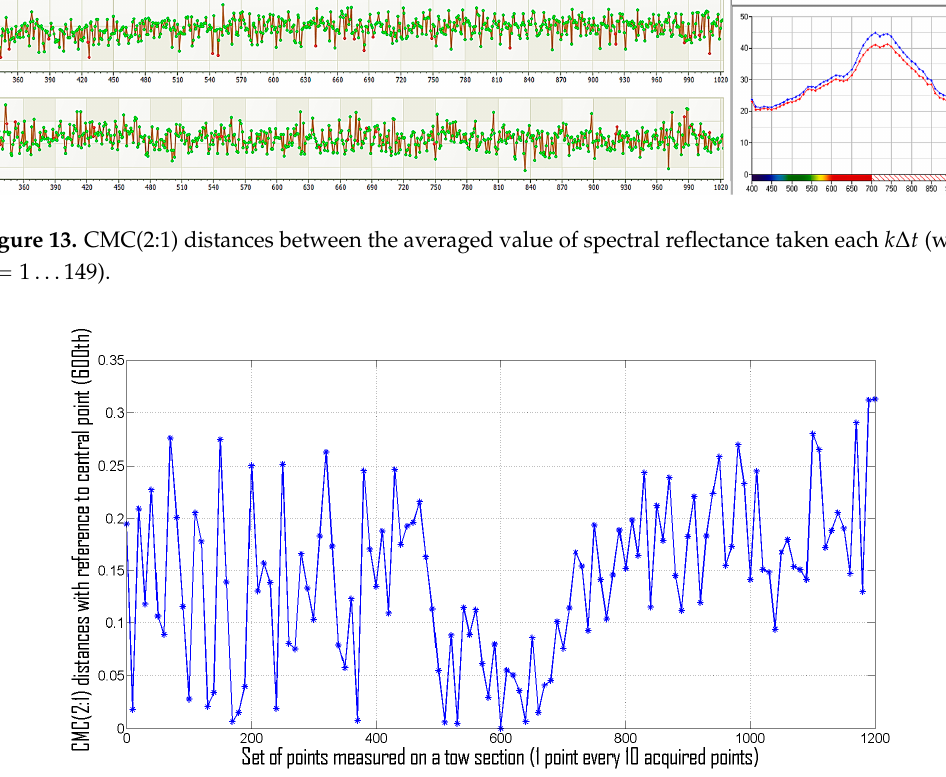
Figure 14. Color distance, in terms of CMC(2:1) between all points of the tow sections and the reference one (central point with index 600).